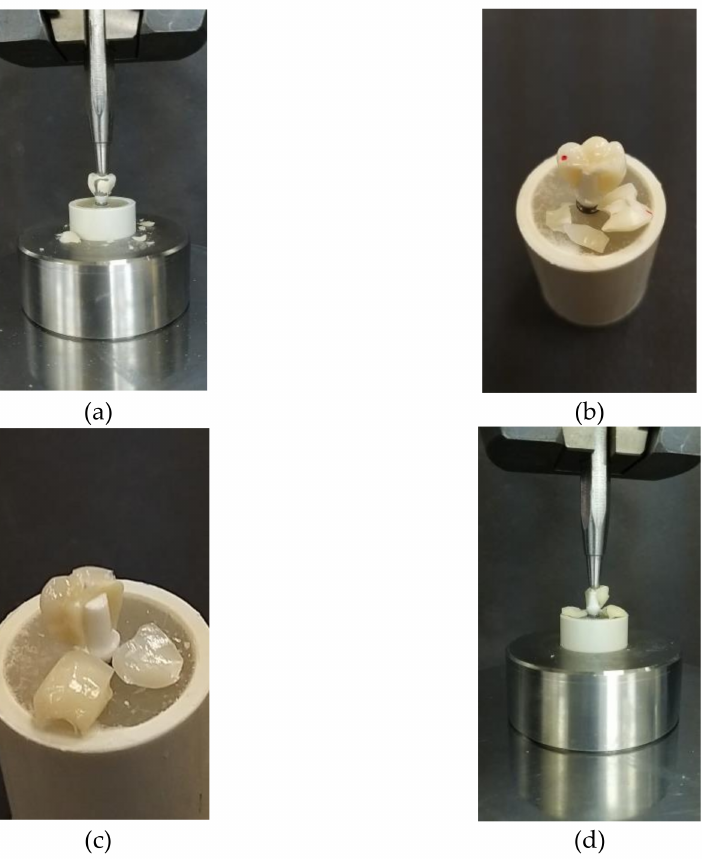
Figure 4. Fractures of the four tested groups on the zirconia abutment: ( a ) Group A: porcelain fused to metal; ( b ) Group B: monolithic zirconia; ( c ) Group C: zirconia coping with a ceramic veneer; ( d ) Group D: full contour all-ceramic lithium